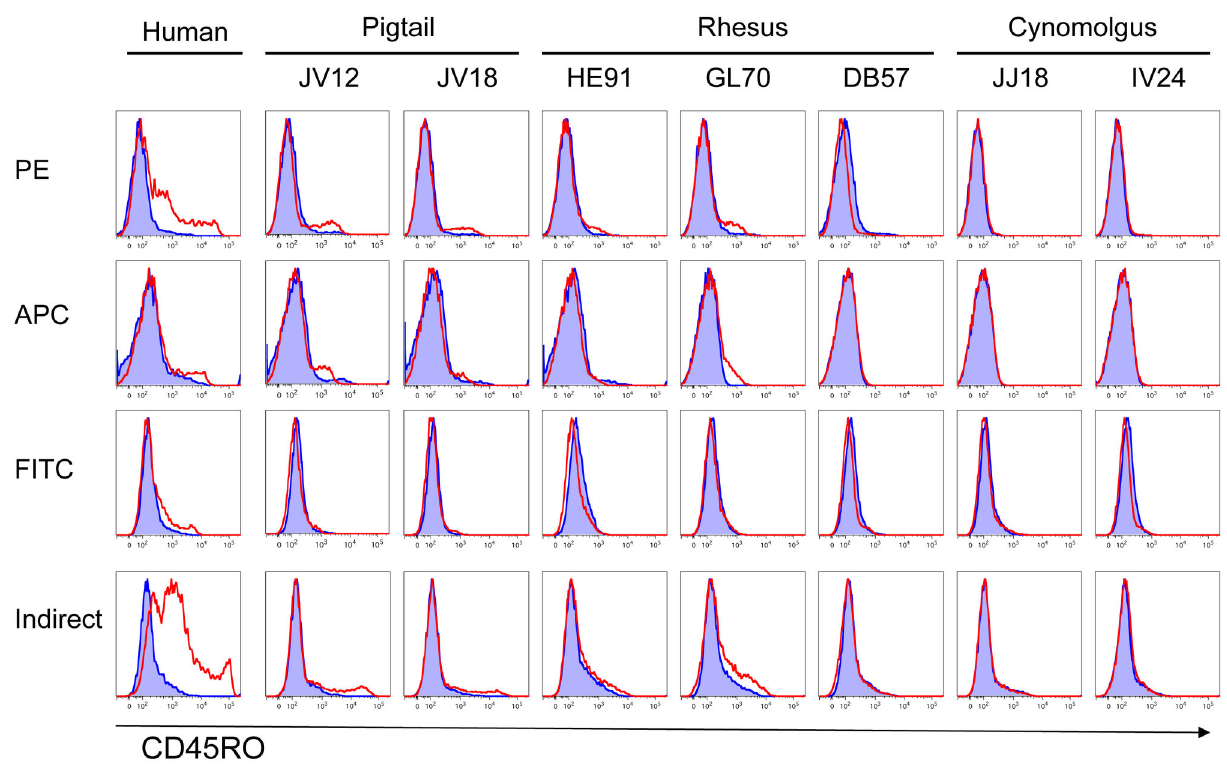
Figure 2. Binding of UCHL1 to lymphocytes from different macaque species. Cryopreserved PBMC from human, and uninfected pigtailed, rhesus and cynomolgus macaques were stained with commercially prepared UCHL1 conjugates with PE, APC, or FITC according to the manufacturer’s recommendation, or by indirect immunofluorescence using 10 µg/ml of unconjugated UCHL1 (red histograms). Directly conjugated isotype controls were run for human and pigtailed macaques (blue histograms), and unstained controls for rhesus and cynomolgus. Data representative of n=2 independent replicate experiments. doi: